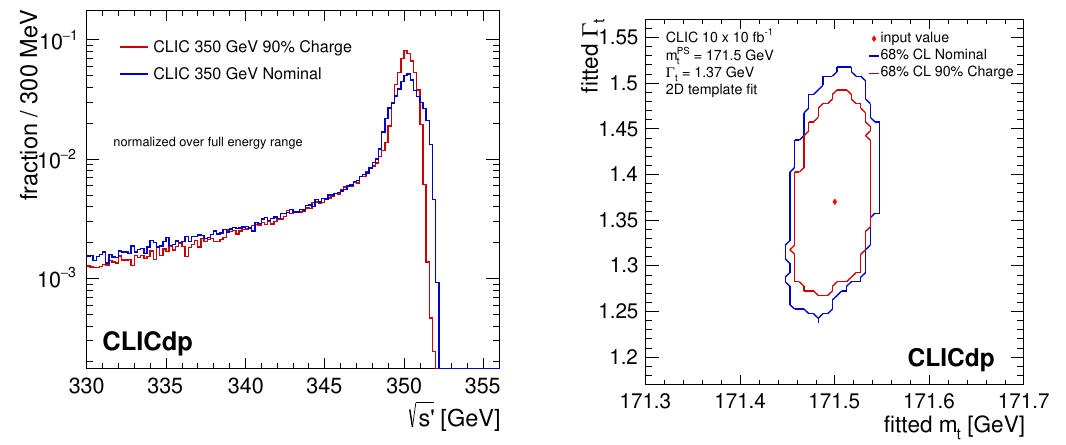
Figure 3 . Left: two scenarios of the CLIC luminosity spectrum for a threshold scan, one based on the nominal accelerator parameters (Nominal) and one optimised for reduced beamstrahlung (90% charge). Right: 68% CL statistical uncertainty contours of the top-quark mass and width fits to the top threshold scan data, for two considered liminosity spectra scenarios, assuming an integrated luminosity of 100 fb − 1 in both cases. Figures taken from